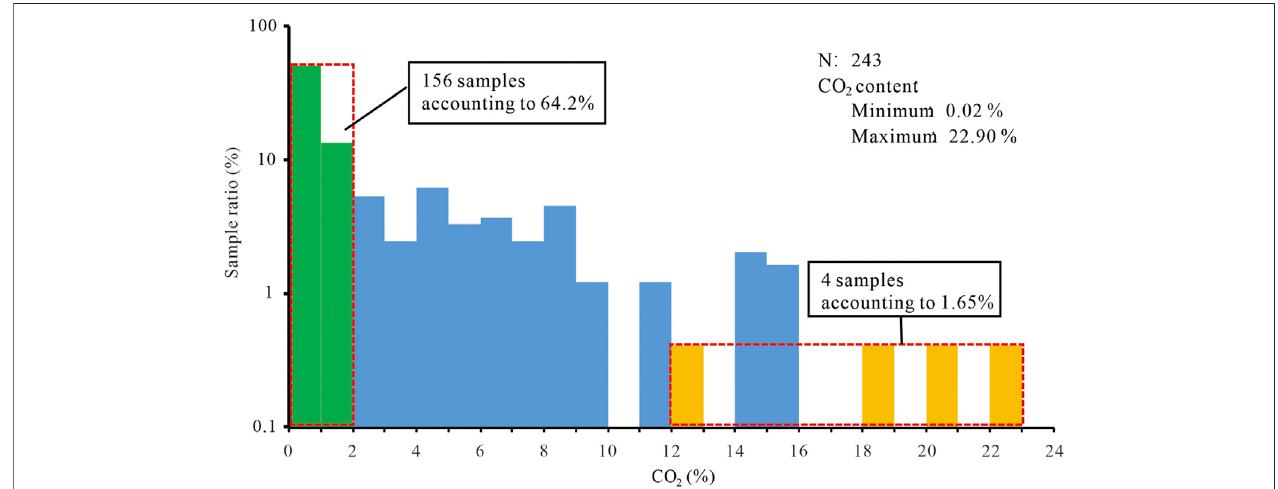
FIGURE 3 | Distribution frequency of CO 2 content of natural gas in the Sichuan Basin.